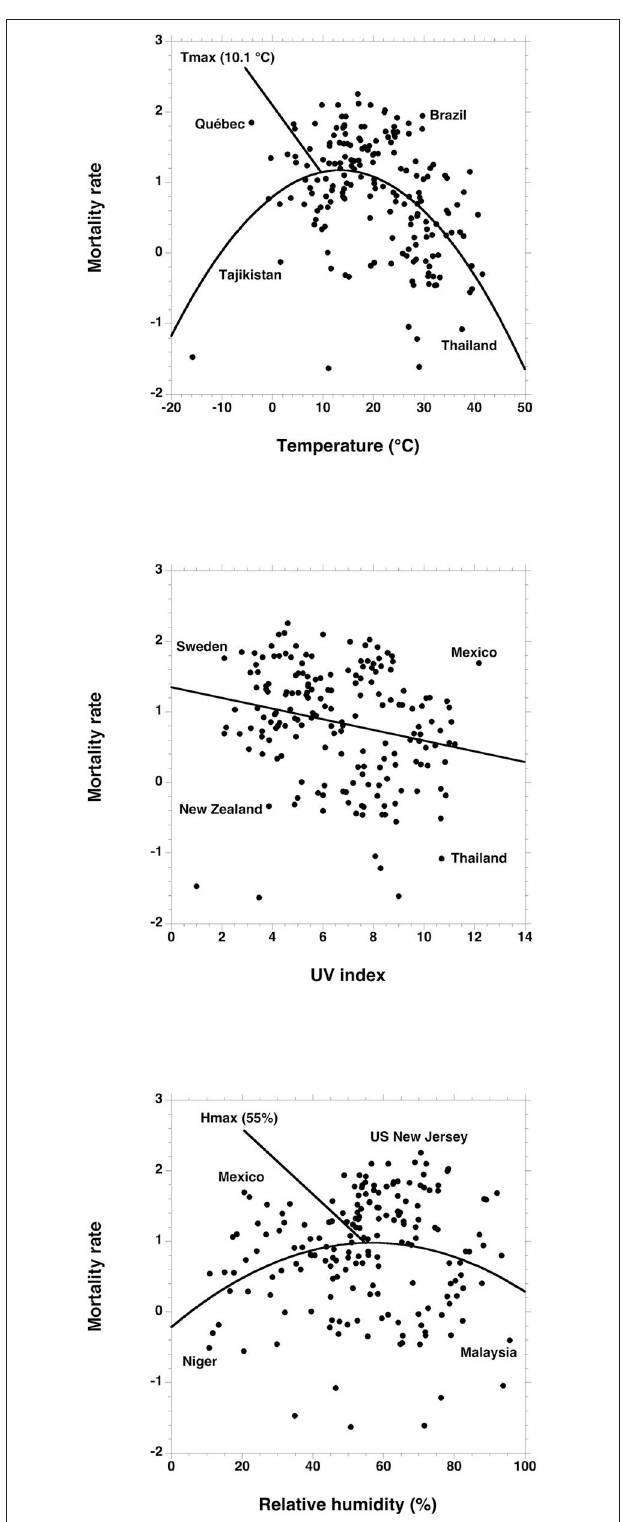
FIGURE 3 | Polynomial or linear regression between the logarithm of the mortality rates due to Covid-19 and the UV index, humidity, and average temperature from the local beginning of the pandemic up to the peak.